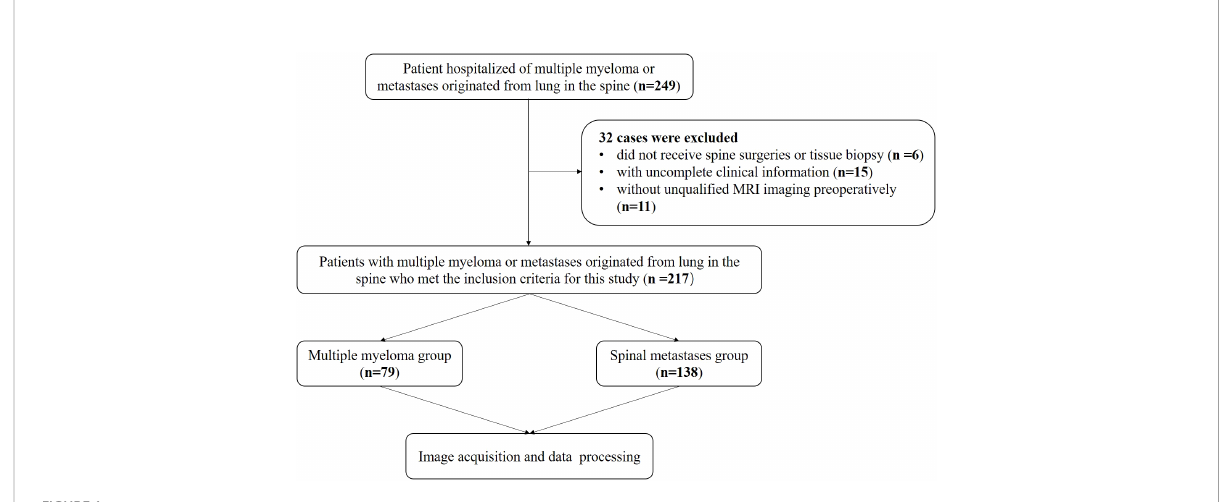
FIGURE 1 The fl owchart of patients ’ inclusion and exclusion